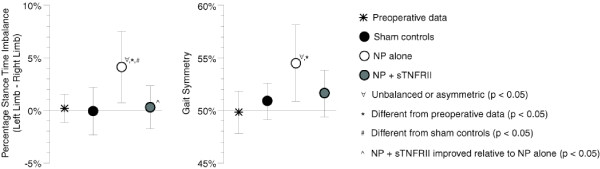
Unbalanced, asymmetric gait in rats with lumbar radiculopathy (five days post-operation). Unbalanced, asymmetric gaits were observed in animals with NP alone (∀, P <0.032), while all other groups did not differ significantly from the mathematical definition of balanced, symmetric gait. The percentage stance time imbalance observed in animals with NP alone differed from both preoperative (*, P = 0.025) and sham controls (#, P = 0.013), and this imbalance was improved in animals receiving NP and sTNFRII relative to animals with NP alone (^, P = 0.012). Gait symmetry of animals with NP alone was also significantly different from pre-operative controls (*, P = 0.009). Data are presented as mean ± standard error.